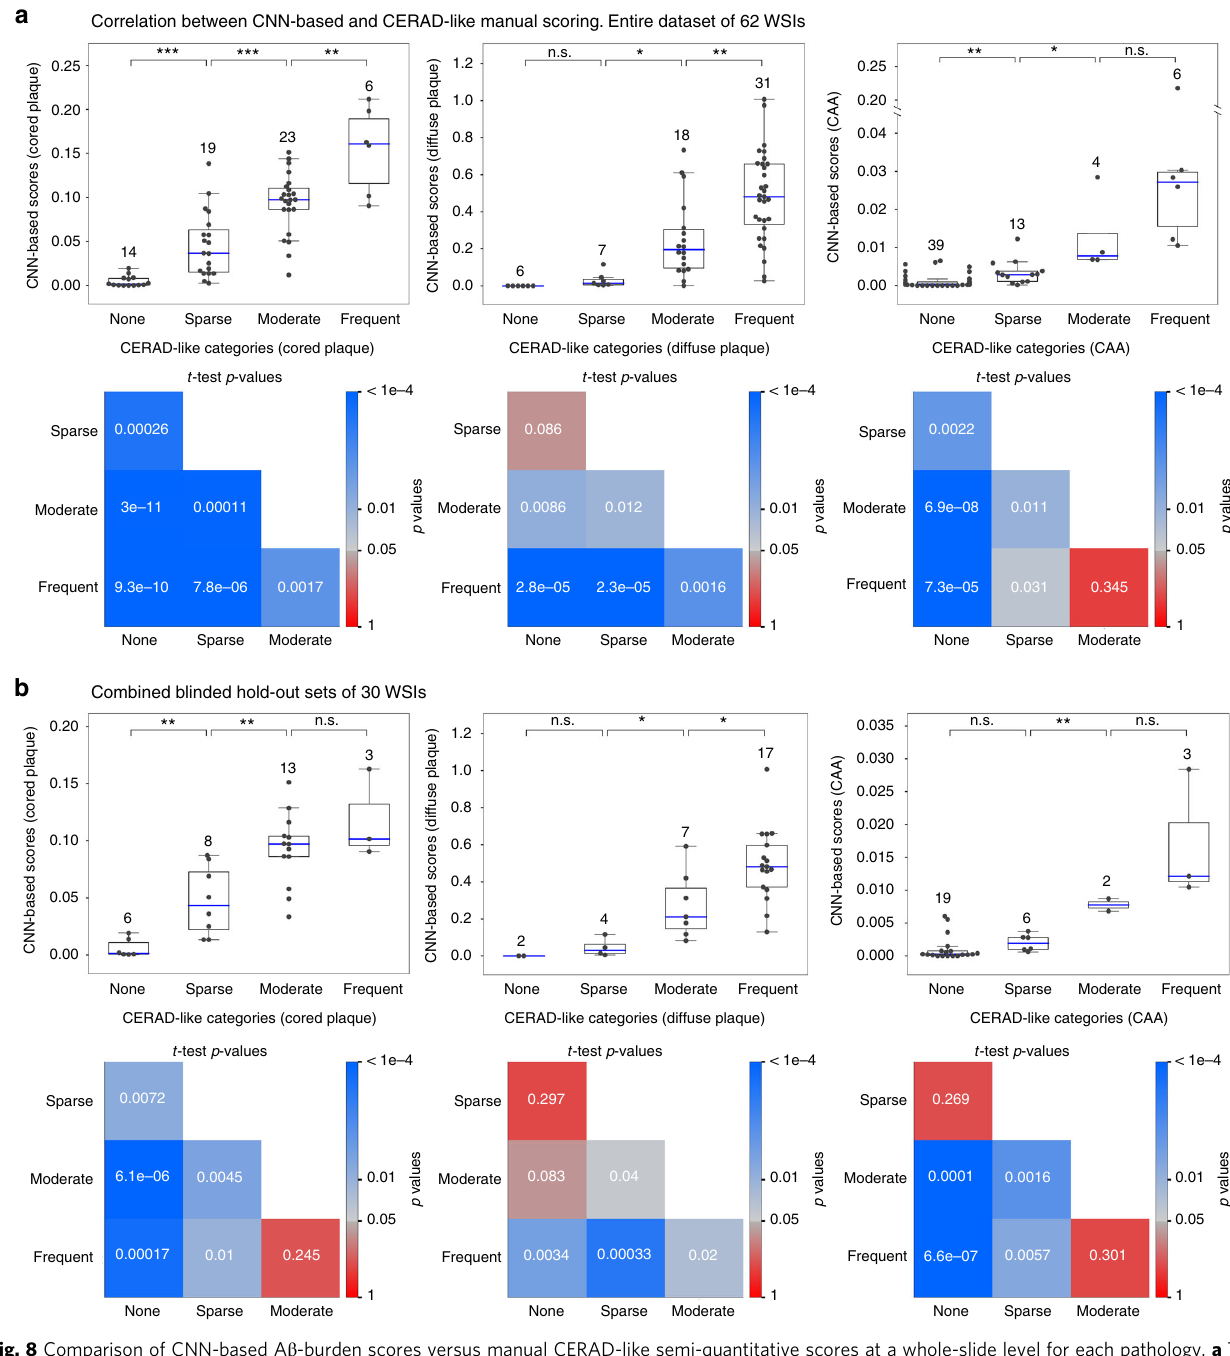
Fig. 8 Comparison of CNN-based A β -burden scores versus manual CERAD-like semi-quantitative scores at a whole-slide level for each pathology. a The automatic and manual scores correlate well across the entire dataset of 62 independent WSIs, comprising the original Phase I-III slide set plus 20 additional blinded WSIs. b Correlations assessed on the 20 blinded WSIs not used in any previous step of the study combined with the 10 WSIs from the original hold-out set, for a total of n = 30 individual cases. Box plots show median (center line inside the box), interquartile range (IQR, bounds of box), minimums and maximums within 1.5 times the IQR (whiskers), and outliers (points beyond the whiskers), with a dot per WSI. p ≥ 0.05 was considered not signi fi cant (ns); * p < 0.05, ** p < 0.01, *** p < 0.001. Matrices in the second row of each panel exhaustively plot p -values of CNN-based score distributions between all pairs of CERAD-like categories for the corresponding box plot, where squares are colored in log scale by p < 1e − 4 (blue) to p = 0.05 (gray) to p = 1 (red; insigni fi cant) using two-sided Student ’ s t -tests. Source data are provided as a Source Data fi